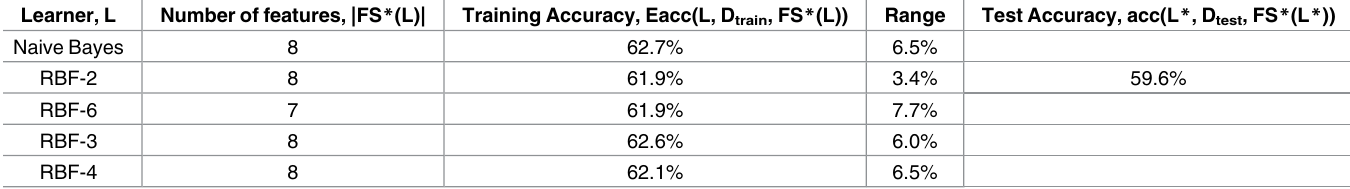
Table 10. ABIDE, personal characteristic data.